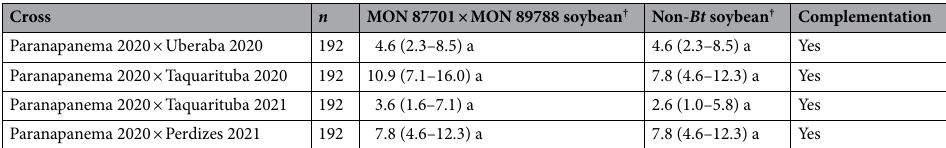
Table 3. Percent mortality (95% CIs) of R. nu populations resistant to MON 87701 × MON 89788 soybean in complementation test for allelism. † Values represent means (95% CI). Mortality on MON 87701 × MON 89788 soybean and non- Bt soybean followed by the same letter in each row are not significantly different due to overlap of 95% CIs. No differences on mortality among MON 87701 × MON 89788 soybean and non- B t soybean indicates that the resistance alleles are probably in a same